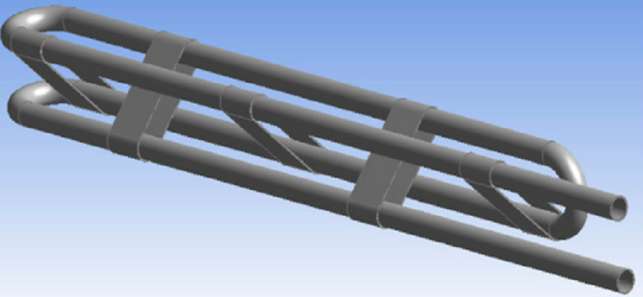
Figure 15. Staggered ring fins [124]. (Permission to reproduce from Ref. [124]).